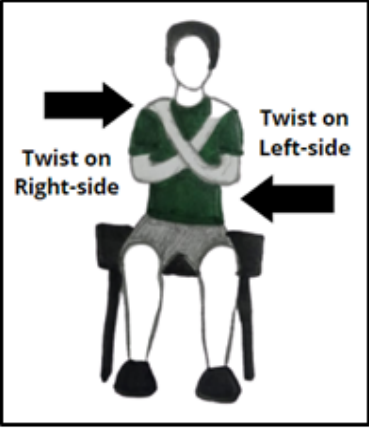
Figure-II: An elaboration to do truck